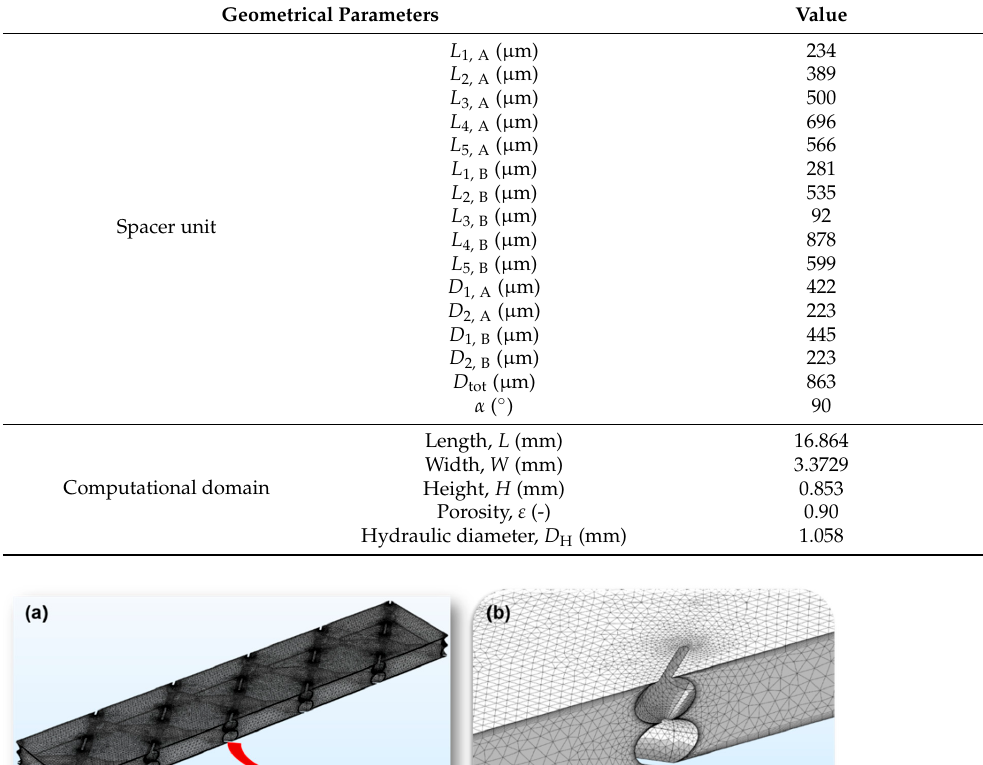
Table 1. The detailed geometrical parameters of the CFD models [44].